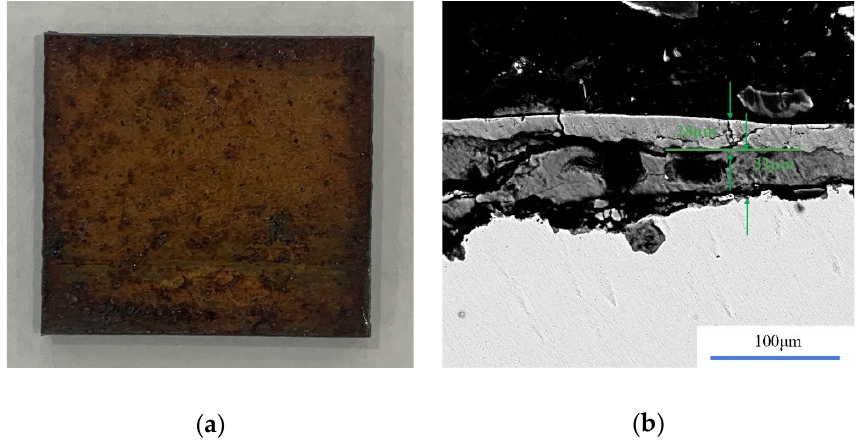
Figure 10. Morphology of sample to be cleaned and thickness of oxide layer. ( a ) Morphology of sample to be cleaned; ( b ) thickness of oxide layer.